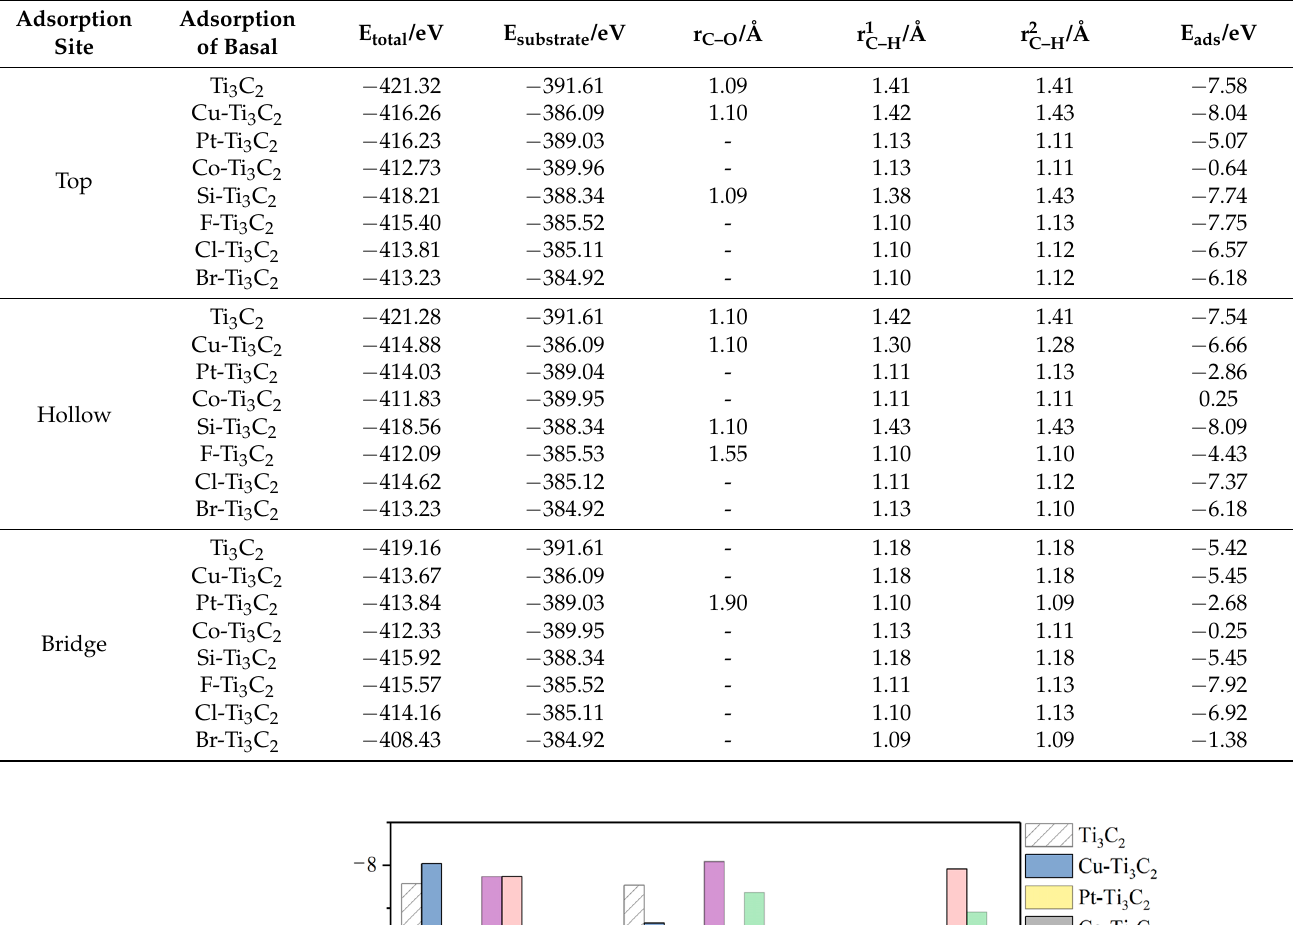
Table 2. Energy and adsorption energy of different adsorption systems.